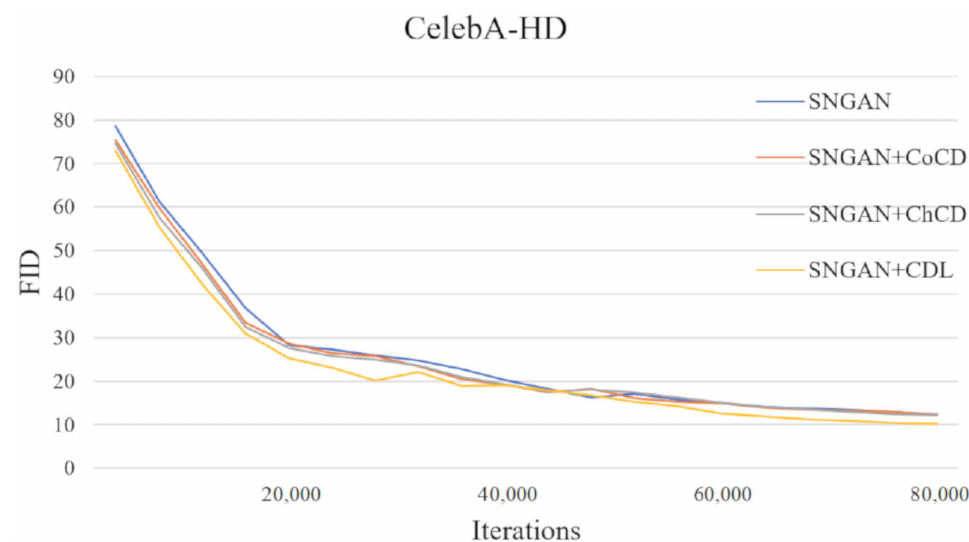
Figure 3. Training stability among SNGAN, SNGAN + CoCD, SNGAN + ChCD, and SNGAN + CDL on CelebA-HD with the hyperparameter set of (0.0, 0.9). All the models utilize the SNGAN backbone with residual blocks.